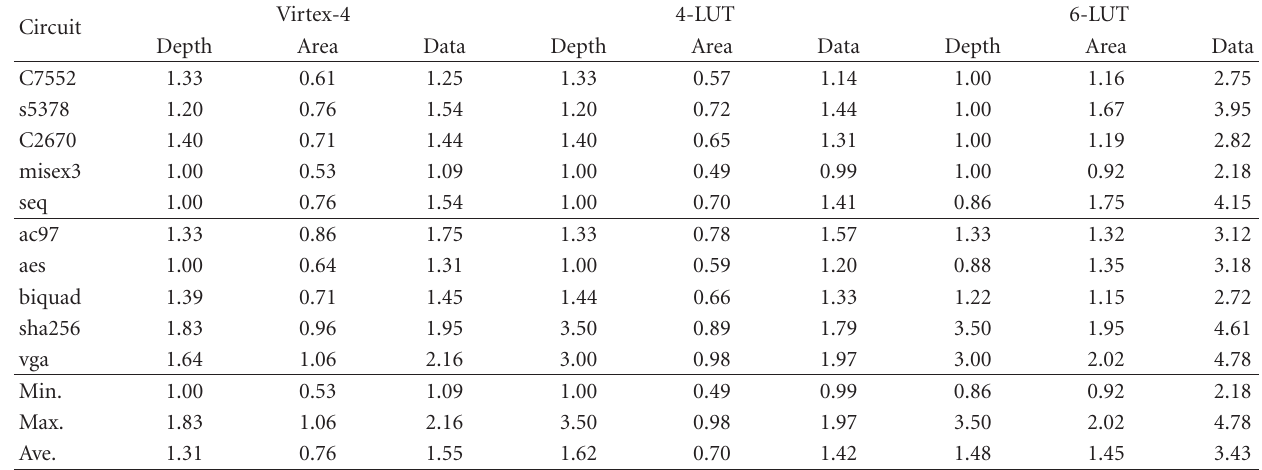
Table 7: Normalized logic depth, area, and configuration